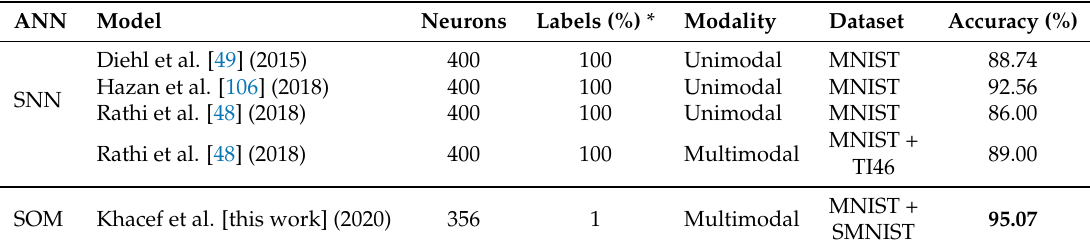
Table 4. Digits classification comparison (bold number represent the best results in the